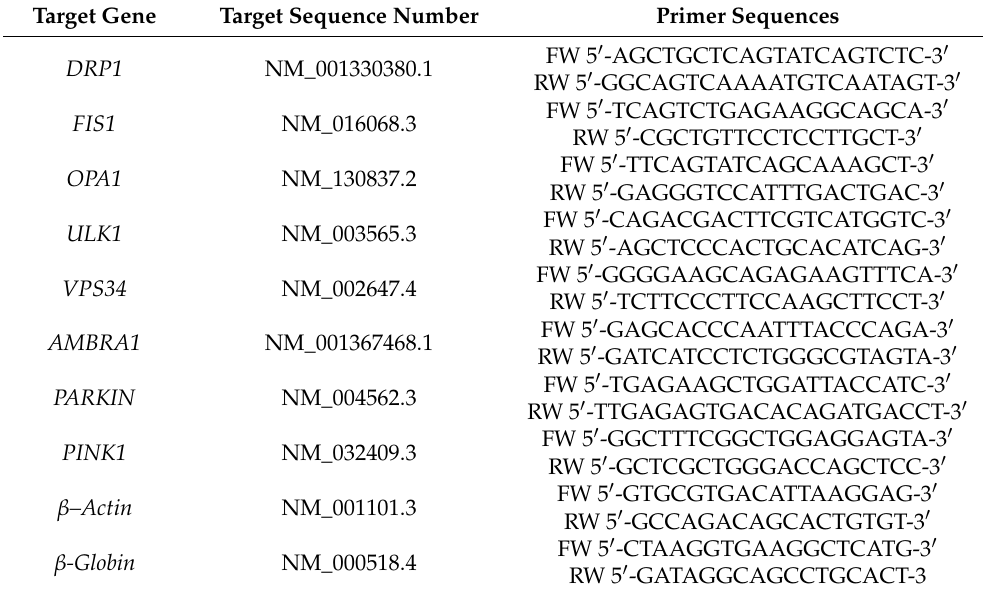
Table 1. Primers used for quantitative Real Time